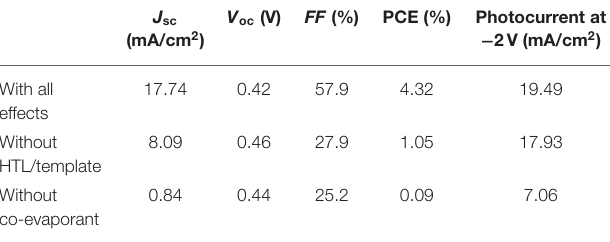
TABLE 1 | Characteristic of the OPVs shown in Figure 7